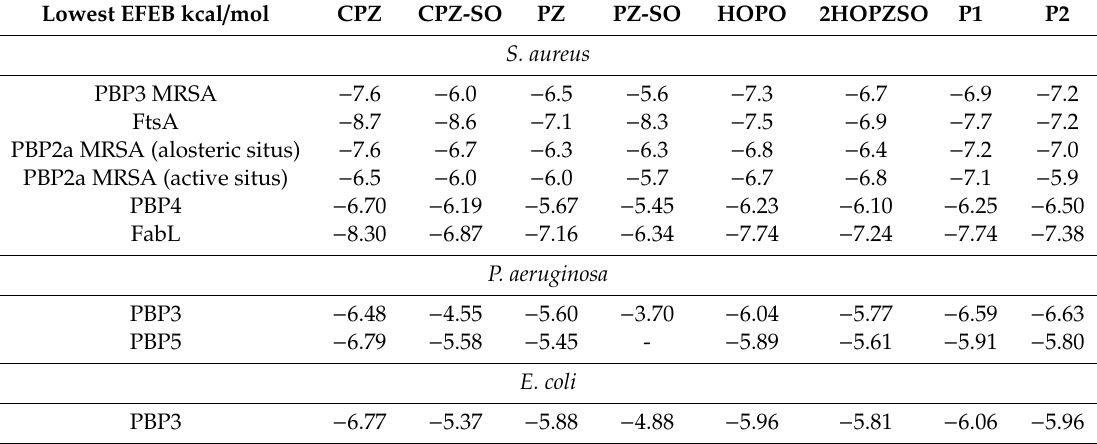
Table 2. Lowest EFEB of CPZ and CPZ photoproducts in interaction with S. aureus six proteins, two P. aeruginosa proteins and one E. coli